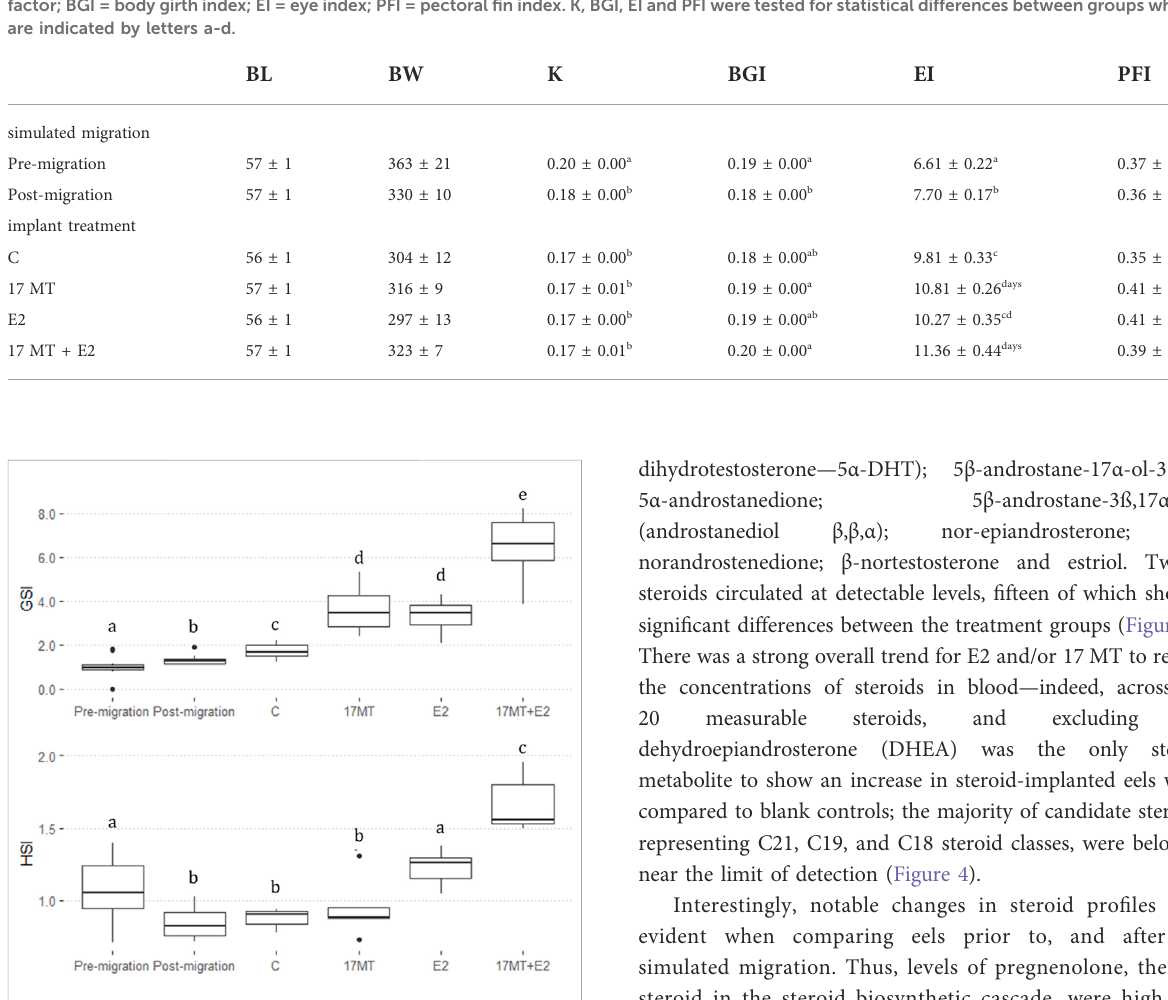
FIGURE 3 Gonadosomatic index (GSI) and Hepatosomatic index (HSI) before-and after simulated migration, and after 2 months of steroid-implanttreatment,with:control(Cgroup;GSI,N=10;HSI, N = 5); 17 α -methyltestosterone (17 MT group; GSI, N = 10; HSI, N = 5); 17 β -estradiol (E2 group; GSI, N = 10; HSI, N = 5), and co-implantation of 17 MT and E2 (17 MT + E group; GSI, N = 10; HSI, N = 5). At each stage, N = 5 eels were dissected for body weight (BW), gonad weight (GW) and liver weight (LW). Another N = 5 eels were scanned to calculate GW using